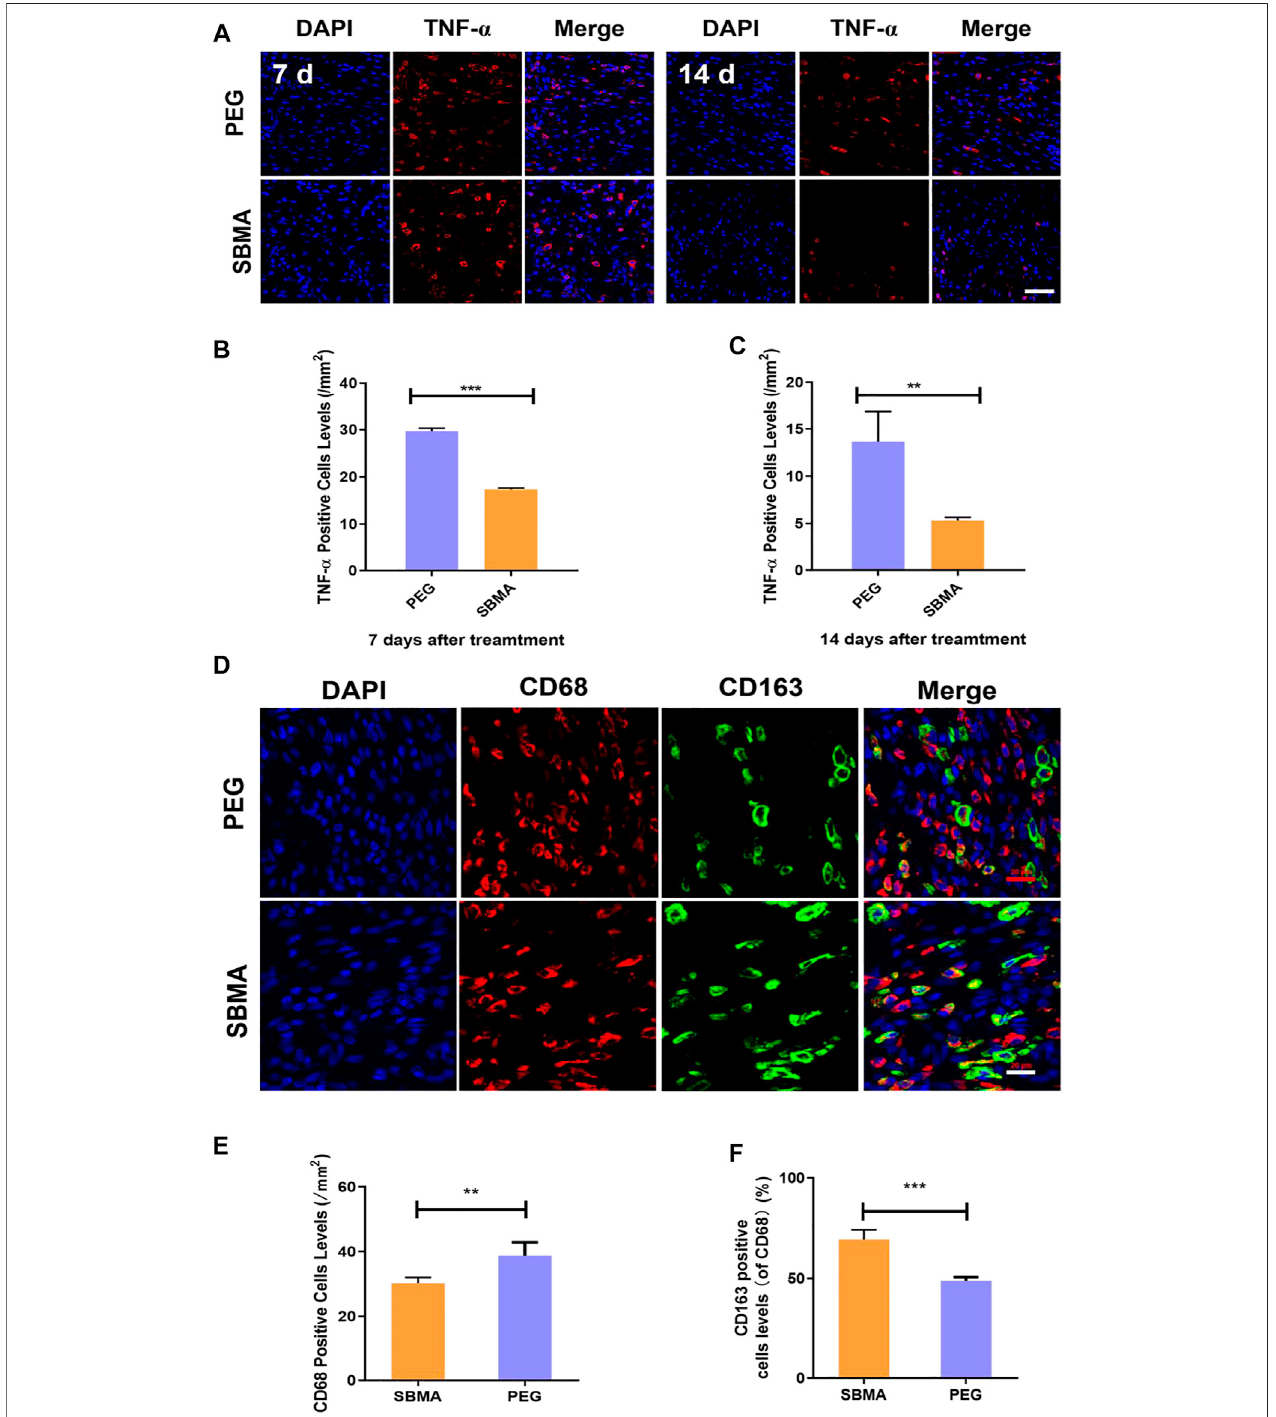
FIGURE7| Invivo expressionofthein fl ammationfactor. (A) Immuno fl uorescentstainingofTNF- α forwoundstreatedbyPEGorSBMAhydrogelsonday7andday 14. Red: TNF- α ; blue: DAPI, nuclei. The scale bar was 50 µm. (B) Quanti fi ed TNF- α – positive cells levels on day 7 at wound sites after the treatments of PEG or SBMA hydrogels. (C) Quanti fi ed TNF- α – positive cell levels on day 14 at wound sites after the treatments of PEG or SBMA hydrogels. (D) Immuno fl uorescent staining of macrophages.CD68:totalmacrophage;CD163:M2phenotypemacrophage;DAPI:nuclei(scalebar (cid:1) 20 μ m). (E) BardiagramoftheCD68-positivecelllevel, n (cid:1) 3. (F) Bar diagram ofthe percentage level ofCD163-positive cell in comparison toCD68-positive cells. Signi fi cant differenceis indicated as** p < 0.01, *** p < 0.001, and n (cid:1) 3.